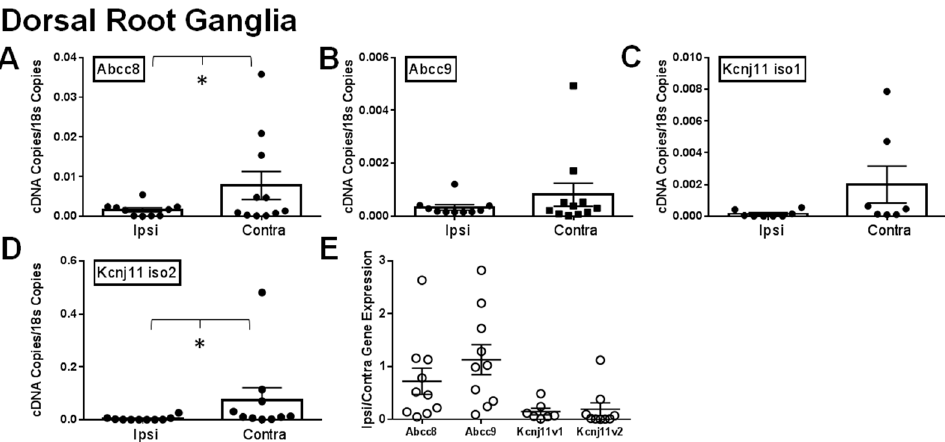
Figure 1. Expression of K ATP channel subunits in dorsal root ganglia are decreased after spinal nerve ligation (SNL). Relative expression of K ATP channel subunits in ipsilateral (Ipsi) and contralateral (Contra) dorsal root ganglia >30 days post SNL. Relative gene expression for Abcc8 (protein: SUR1, A ), Abcc9 (protein: SUR2, B ), Kcnj11 iso1 (protein: Kir6.2, C ) and Kcnj11 iso2 (protein: Kir6.2, D ) compared against matching tissue expression for 18s . * P < 0.05 comparison between Ipsi vs. Contra . ( E ). Data in A–D are expressed as mean fold change (Ipsi/Contra) between matching samples.